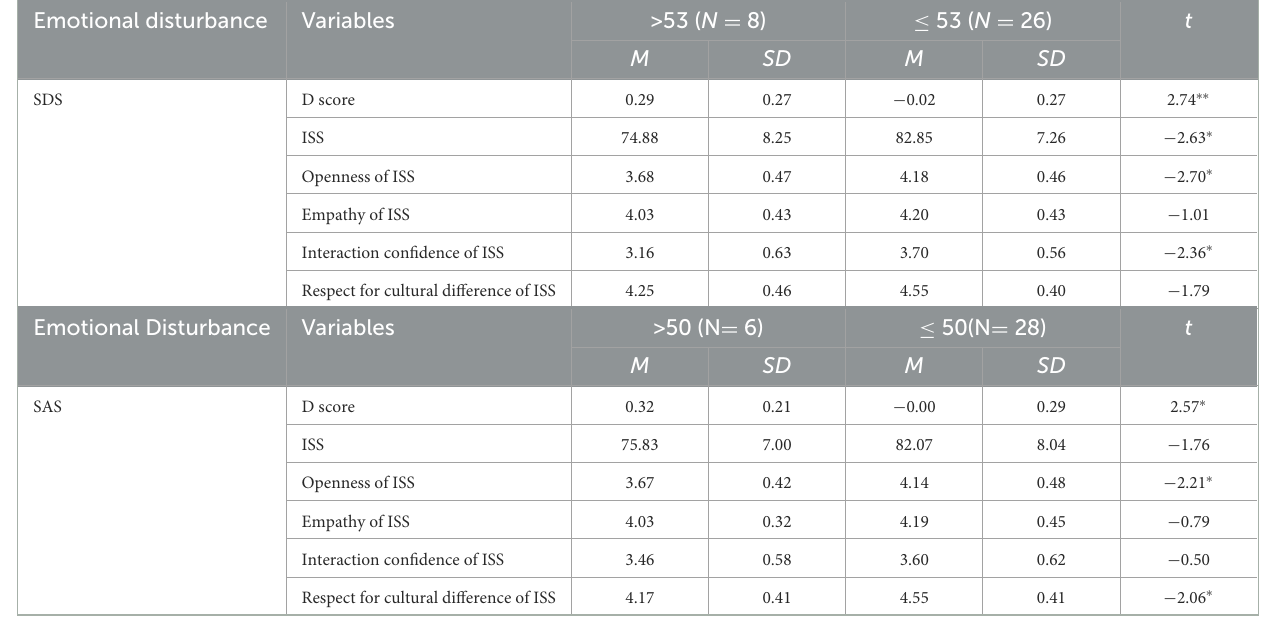
TABLE 2 Differences in D score and the score of ISS classified on the critical value of SDS/SAS ( N = 34). Emotional disturbance